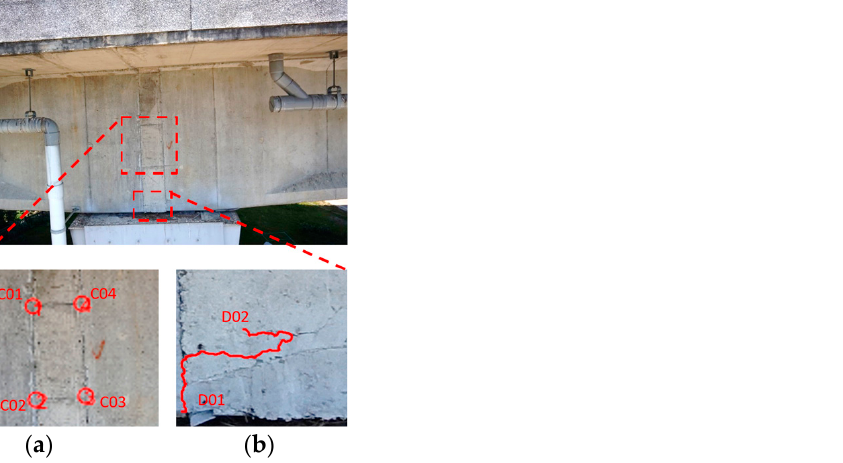
Figure 15. Damage on the side of the main beam at the test site: ( a ) connected concrete cracks; ( b ) unconnected concrete cracks.